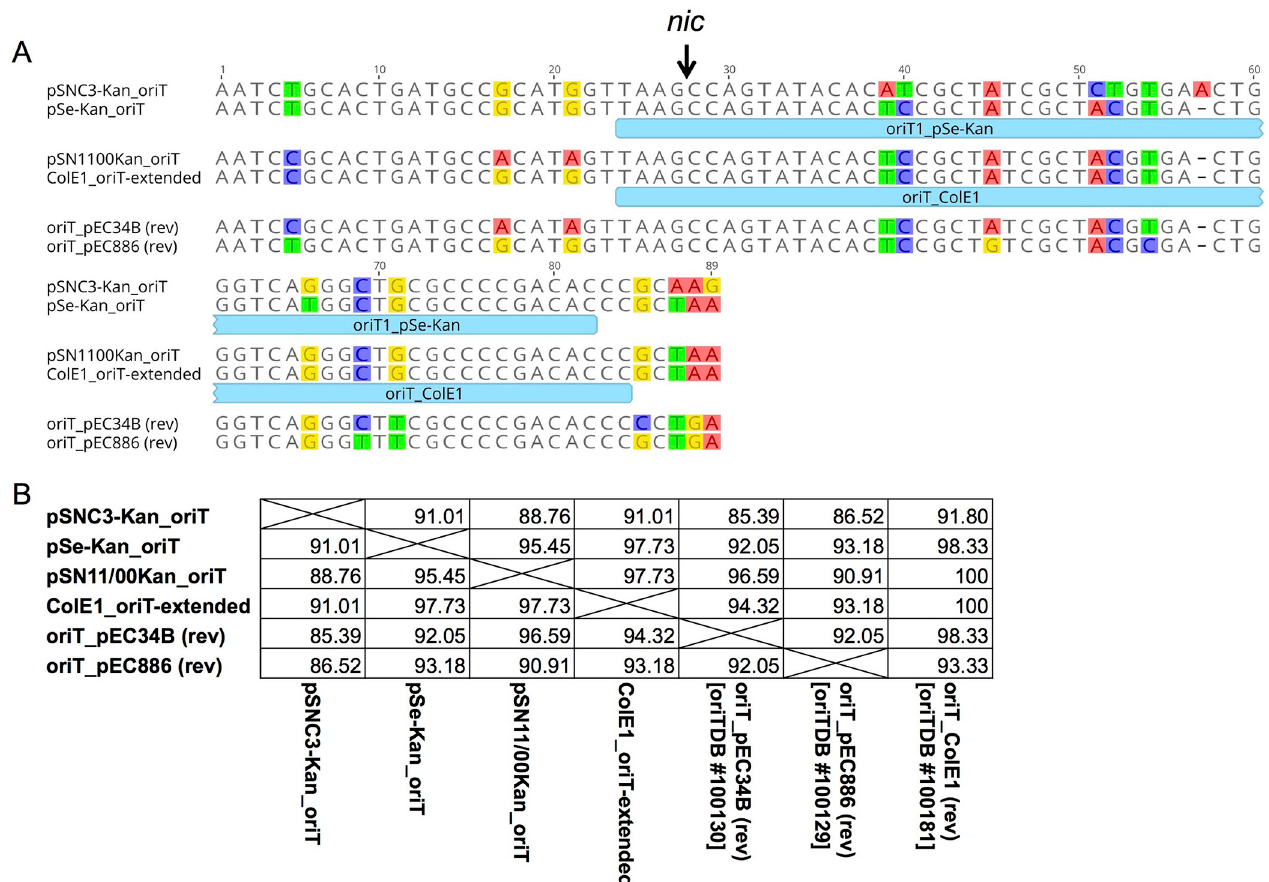
Fig 3. Comparison of oriT of pSNC3-Kan to other plasmids. (A) oriT sequence alignment. Non-identical bases are highlighted in color. Downward arrow indicates the nic site based on pEC34B annotation; the nicked strand is complementary to the sequence shown. (B) Pairwise percent identity table. Sequence labels started with “oriT” were retrieved from the oriT Finder database oriTDB and accession numbers are indicated within the square brackets in the pairwise comparison table. pSe-Kan oriT region was annotated based on the alignment to pEC34B, and is extended beyond the “oriT1_pSe-Kan” in oriTDB (shown as light blue box under the sequence). ColE1 sequence was extended to the same span as that of “oriT_pEC34B”; the “oriT_ColE1” in oriTDB is shown as light blue box under the sequence.